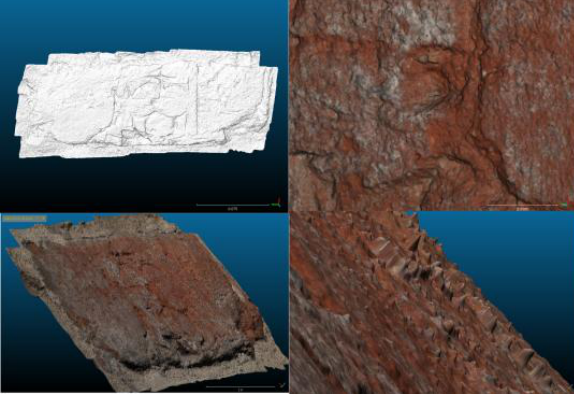
Figure 7. The 3D mesh model of the W-9-3 engraving generated based on the high point cloud (without and with textures) For the needs of comparing, models from other clouds of the lower density were also generated (the medium and low point